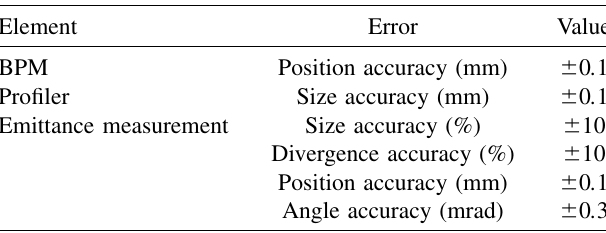
TABLE VI. The amplitudes of errors for the